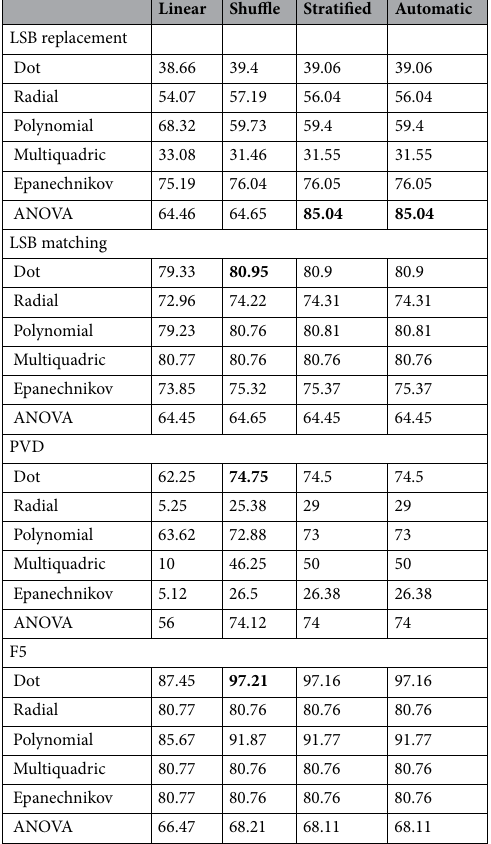
Table 7. Classification of uncalibrated images with cross-validation using SVM for random %. Significant values are in bold.